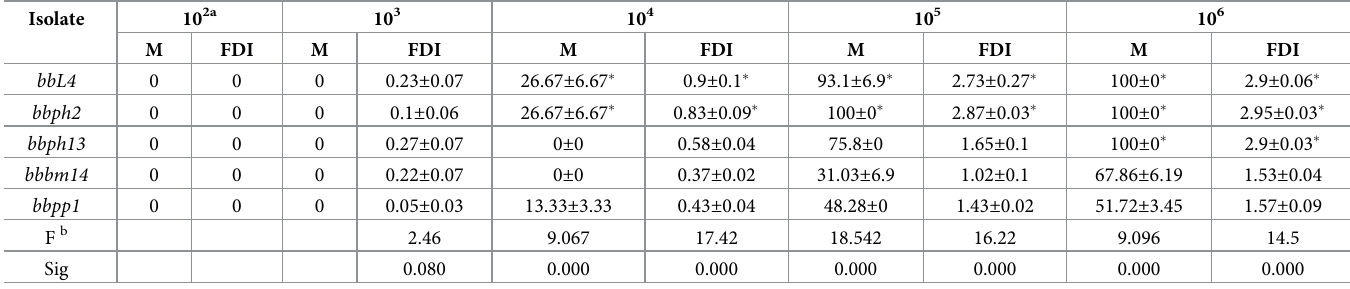
Table 1. Mortality of the larvae and fungal development index at the 10 th day of treatment. Isolate